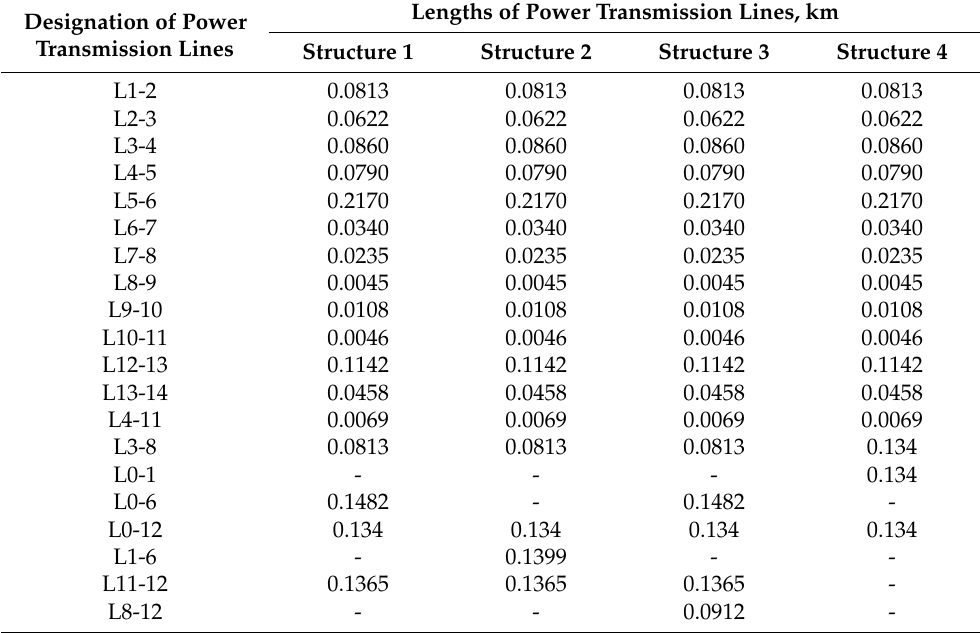
Table 4. Lengths of power transmission lines for different alternative structures of flexible distribution network.